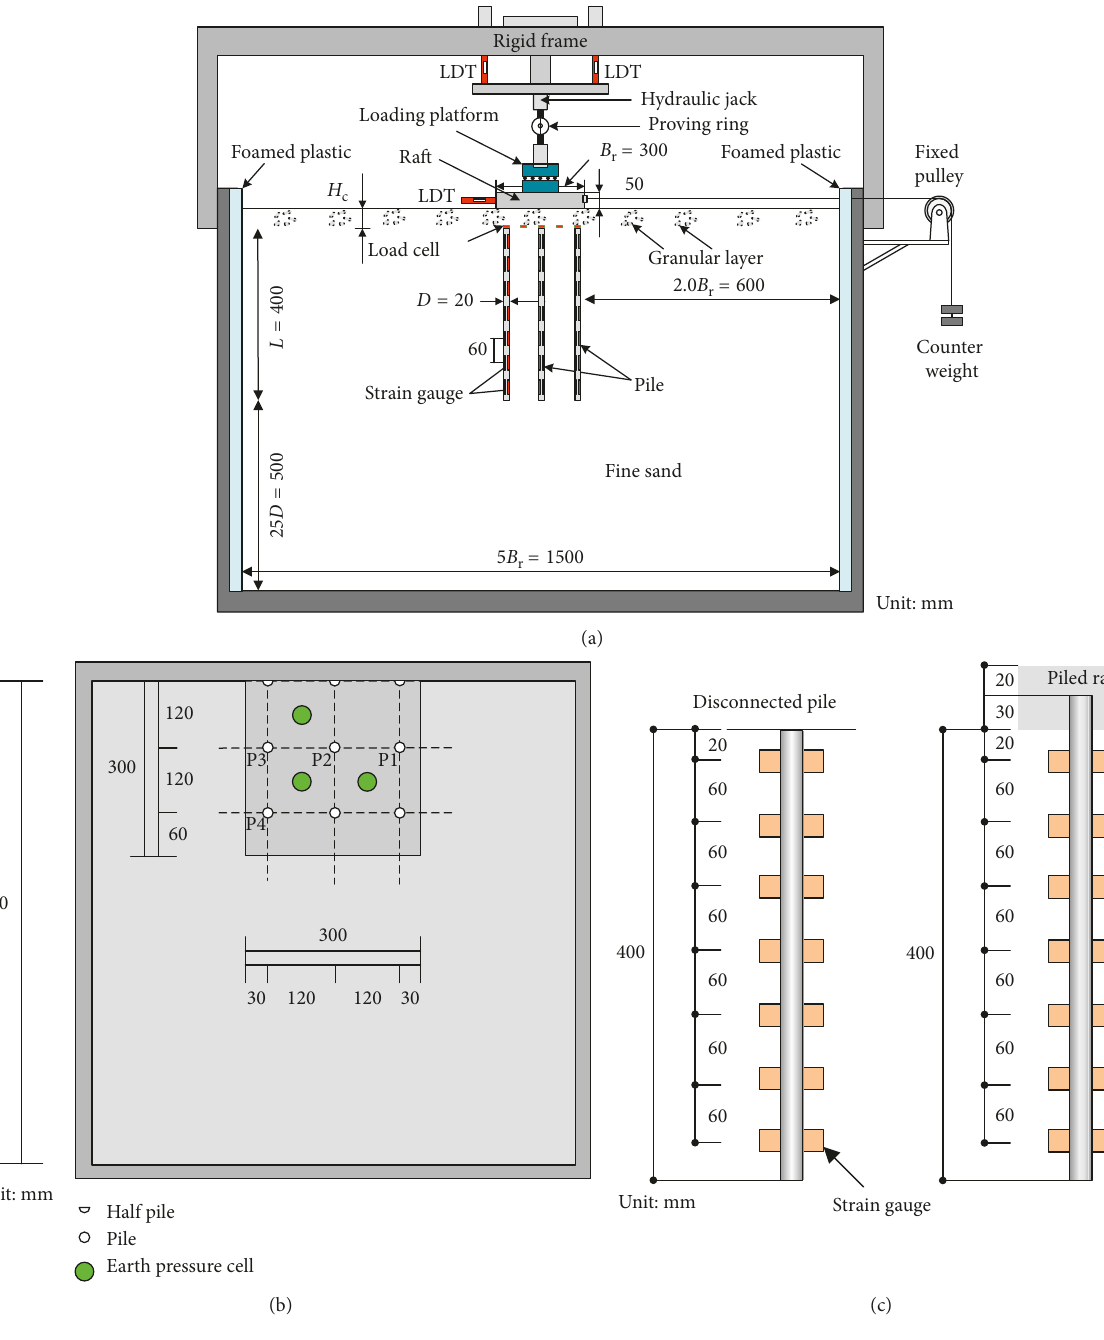
Figure 2: Sketch map of the test model. (a) Side view. (b) Top view. (c) Attached strain gauge